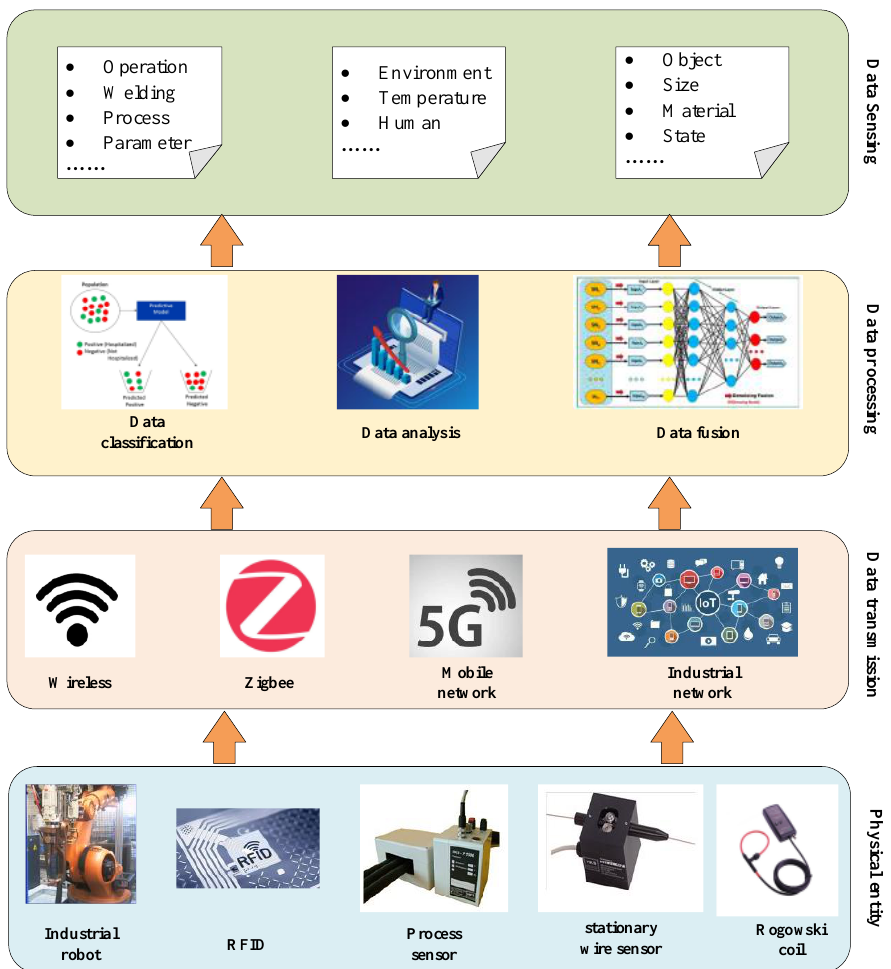
Figure 3. Real-time acquisition system for resistance spot welding process.